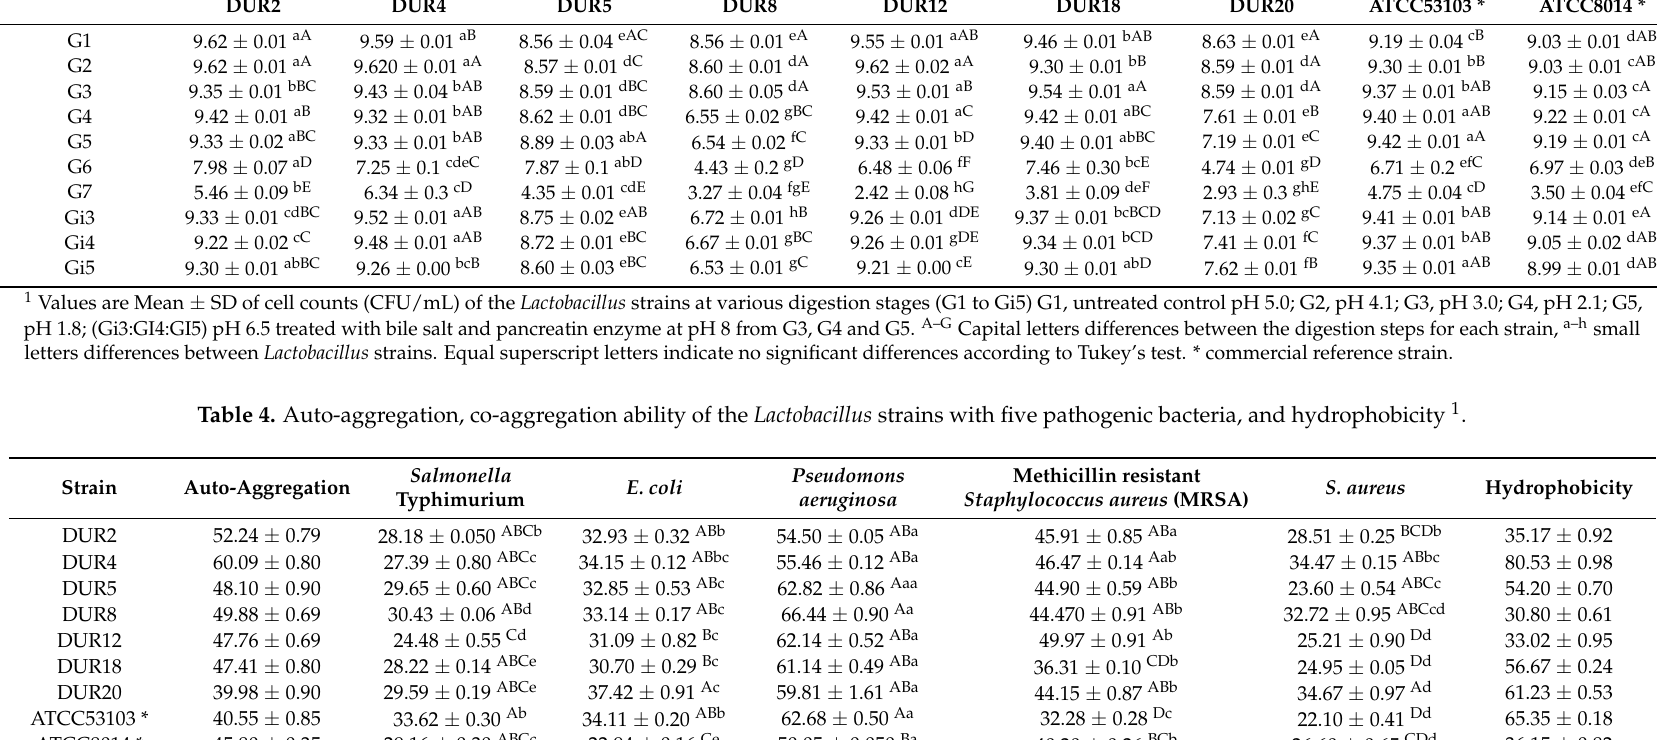
Table 3. Viable cell count [Log 10 (CFU/mL)] of seven Lactobacillus strains at different gastric (G) and gastrointestinal (GI) digestion stages in a dynamic in vitro model 1 . Digestion Stage